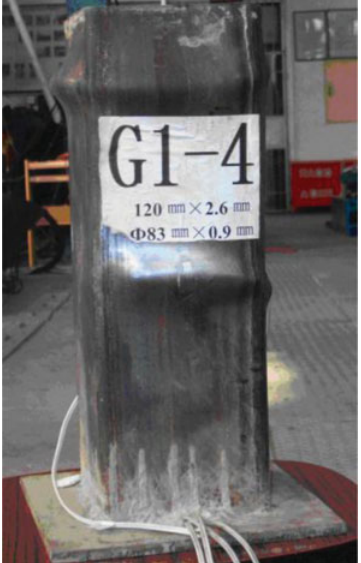
Fig. 3. Typical failure mode of specimen